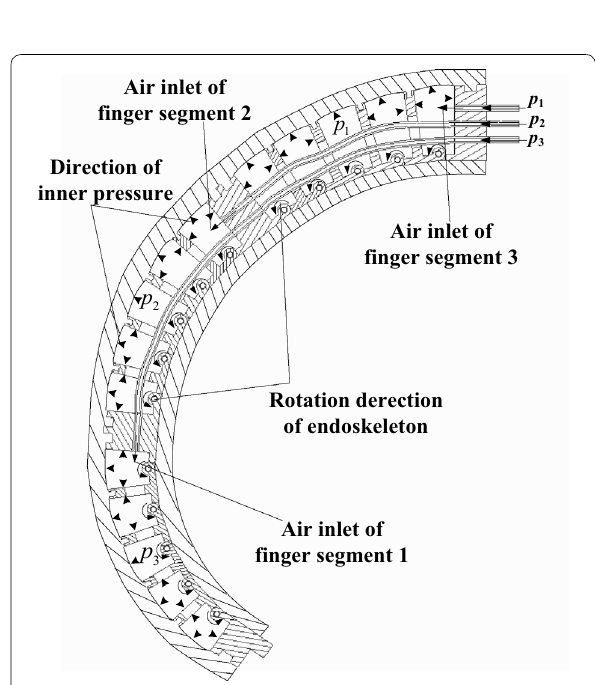
Figure 3 Schematic of bending of the soft finger